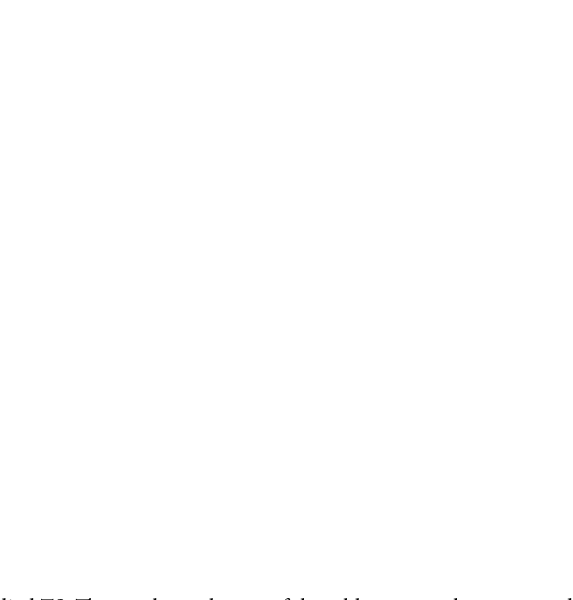
Table 3. The result of the KS-test for all studied TS. The two last columns of the table present the t-tests and p values for which the null hypothesis (random indicator) is